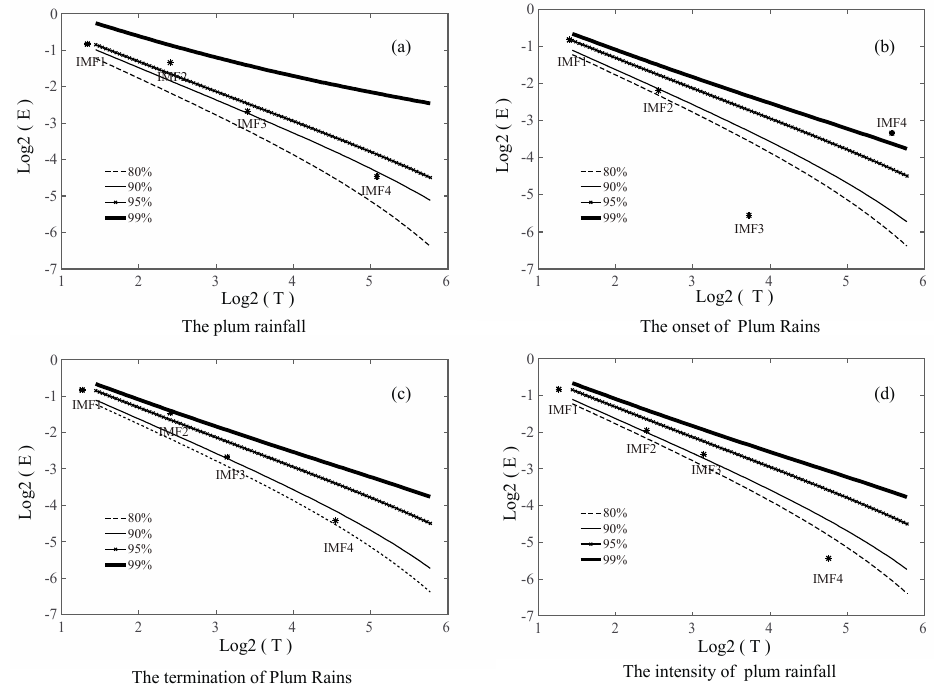
Figure 5. Significance test for the IMFs of ( a ) the plum rainfall, ( b ) the onset of Plum Rains, ( c ) the termination of Plum Rains, and ( d ) the intensity of plum rainfall during the period of 1960 to 2012.